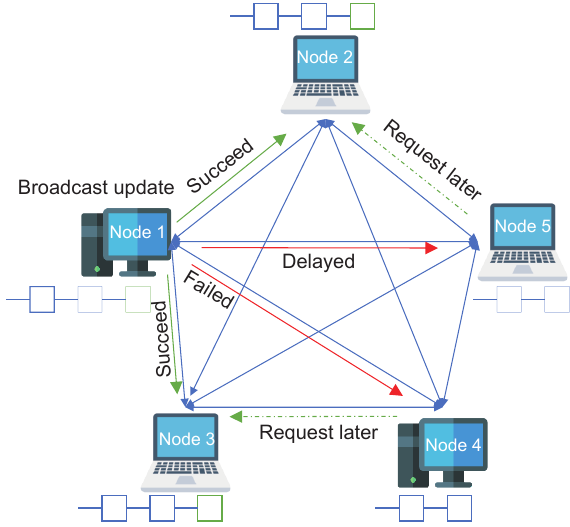
Fig. 5 Blockchain peer-to-peer network communication